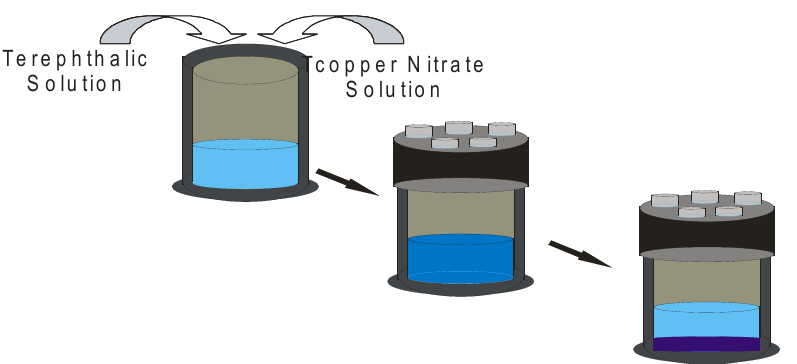
Figure 5. Schematic representation of solvothermal synthesis of MOFs.